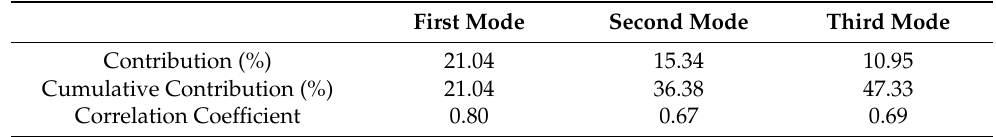
Table 2. The differences in the contribution rates of the first three SVD modes between the spring snowmelt over the TP and summer precipitation in